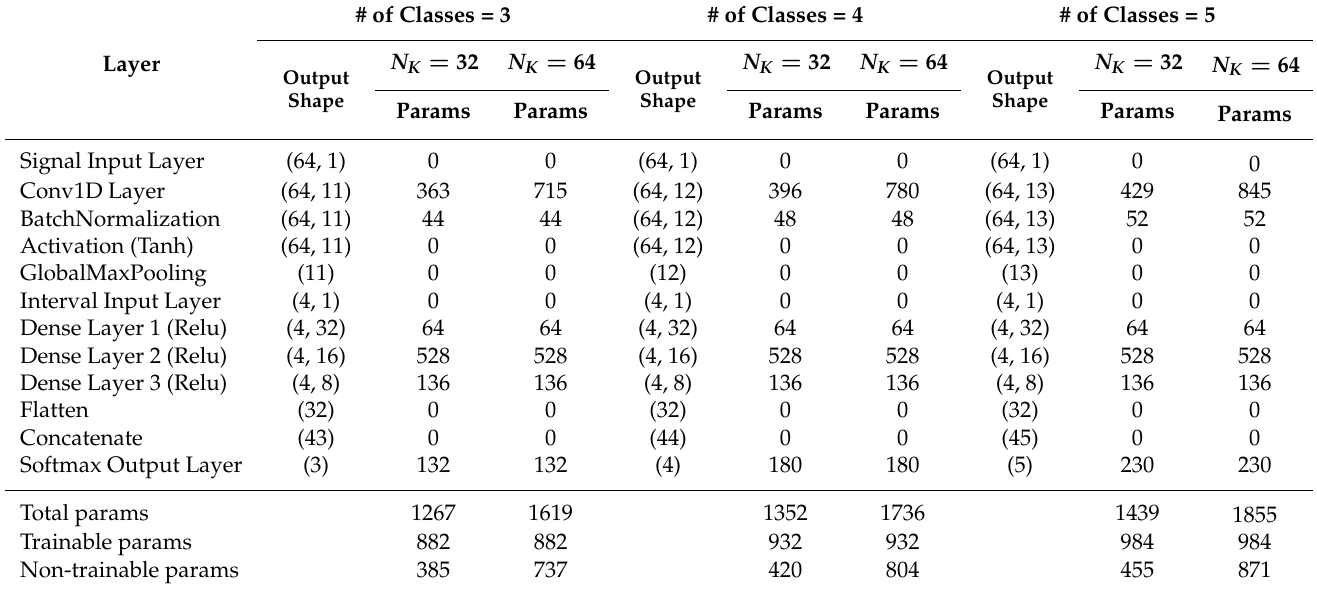
Table 3. Architecture of different Conv1D CNN model variants for the signal and derivative inputs. The output shape comprises (the number of nodes and the number of channels). The Conv1D layer parameters can be set as trainable or non-trainable in different model